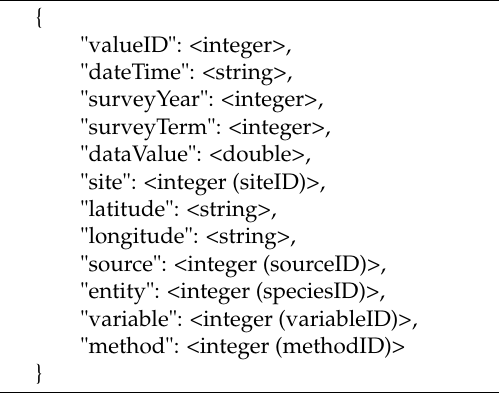
Algorithm 4. Representation schema for the Observation collection